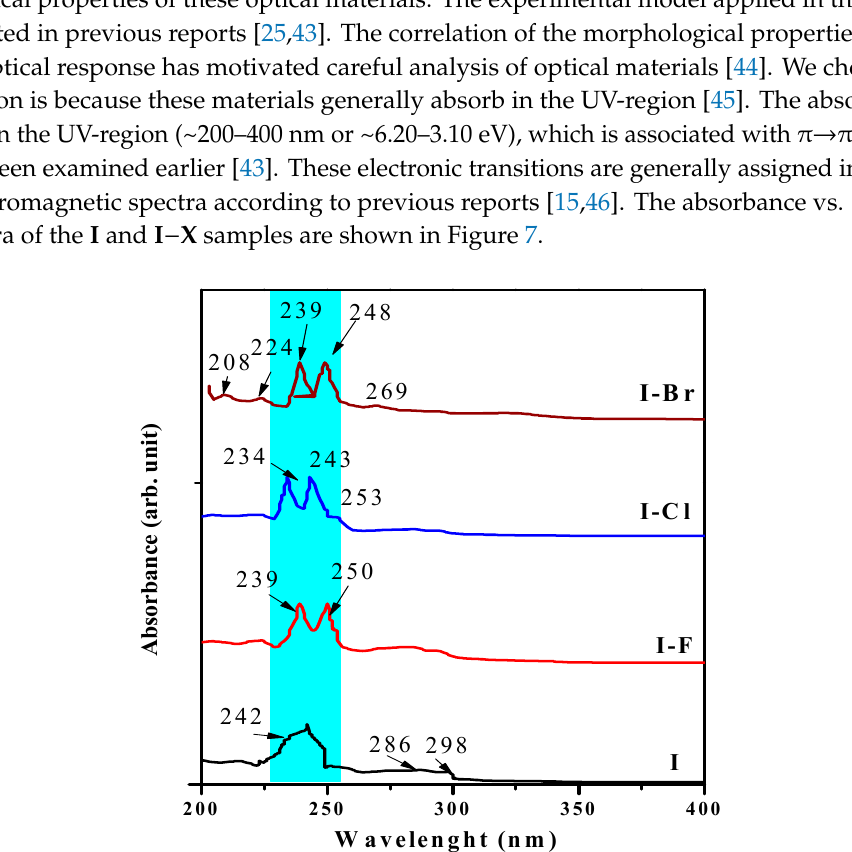
Figure 6. XRD patterns of I , I − F , I − Cl , and I − Br crystals.